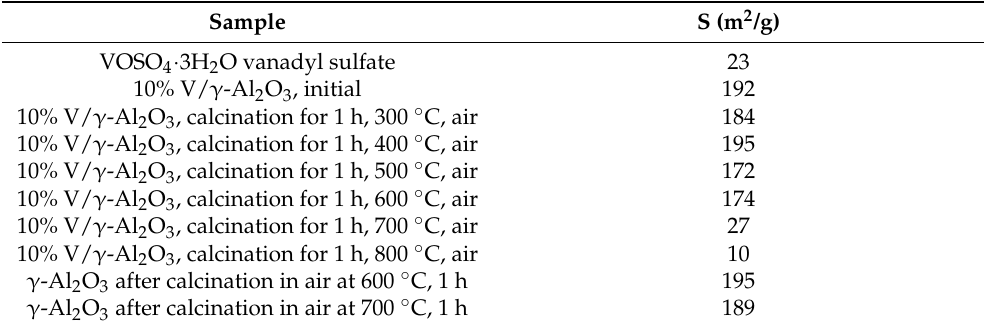
Table 3. Specific surface area of the aluminium–vanadium phases after calcination in air at different temperatures.